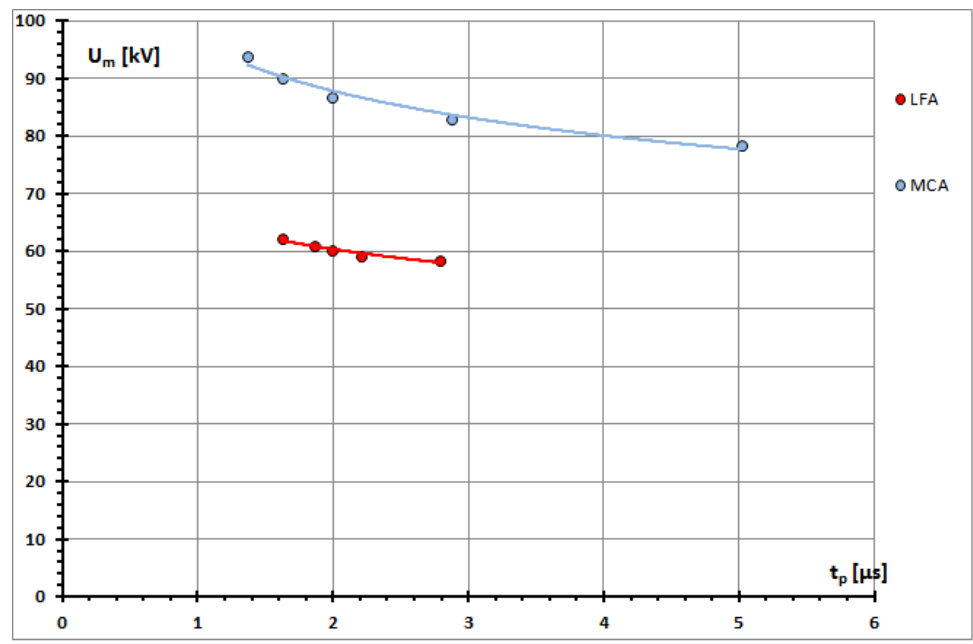
Figure 13. Comparison of voltage–time characteristics for the MCA and the LFA for positive polarity.